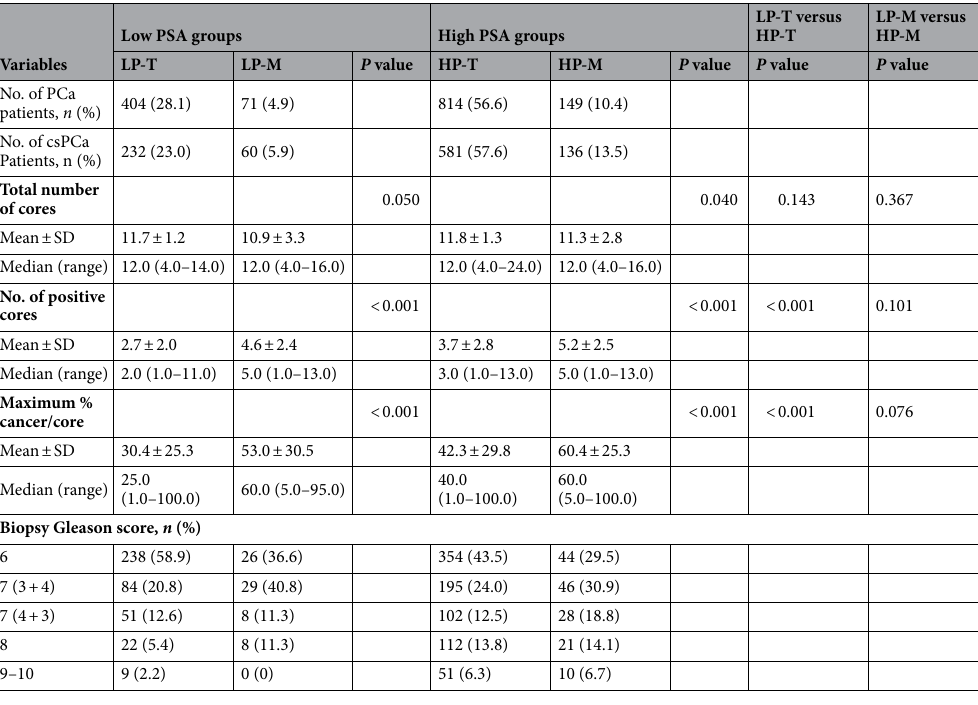
Table 2. Pathologic characteristics of men diagnosed with prostate cancer. PCa Prostate cancer, PSA Prostate-specific antigen, TRUS-Bx Transrectal ultrasound-guided biopsy, MRI-TBx Magnetic resonance imaging-targeted biopsy, SD Standard deviation. Groups: LP-T (men with PSA 2.5–4.0 ng/mL who underwent TRUS-Bx); LP-M (men with PSA 2.5–4.0 ng/mL who underwent MRI-TBx); HP-T (men with PSA 4.0–